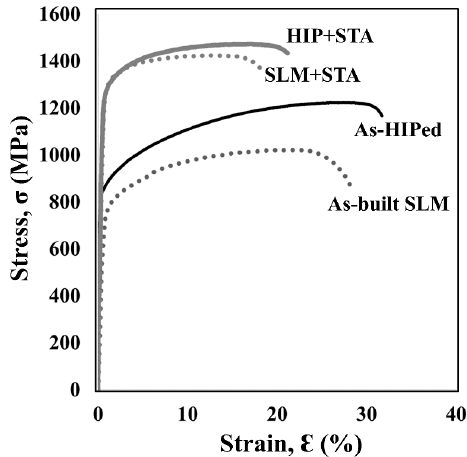
Figure 8. Engineering stress-strain curves of HIP specimen and SLM specimens at room temperature.